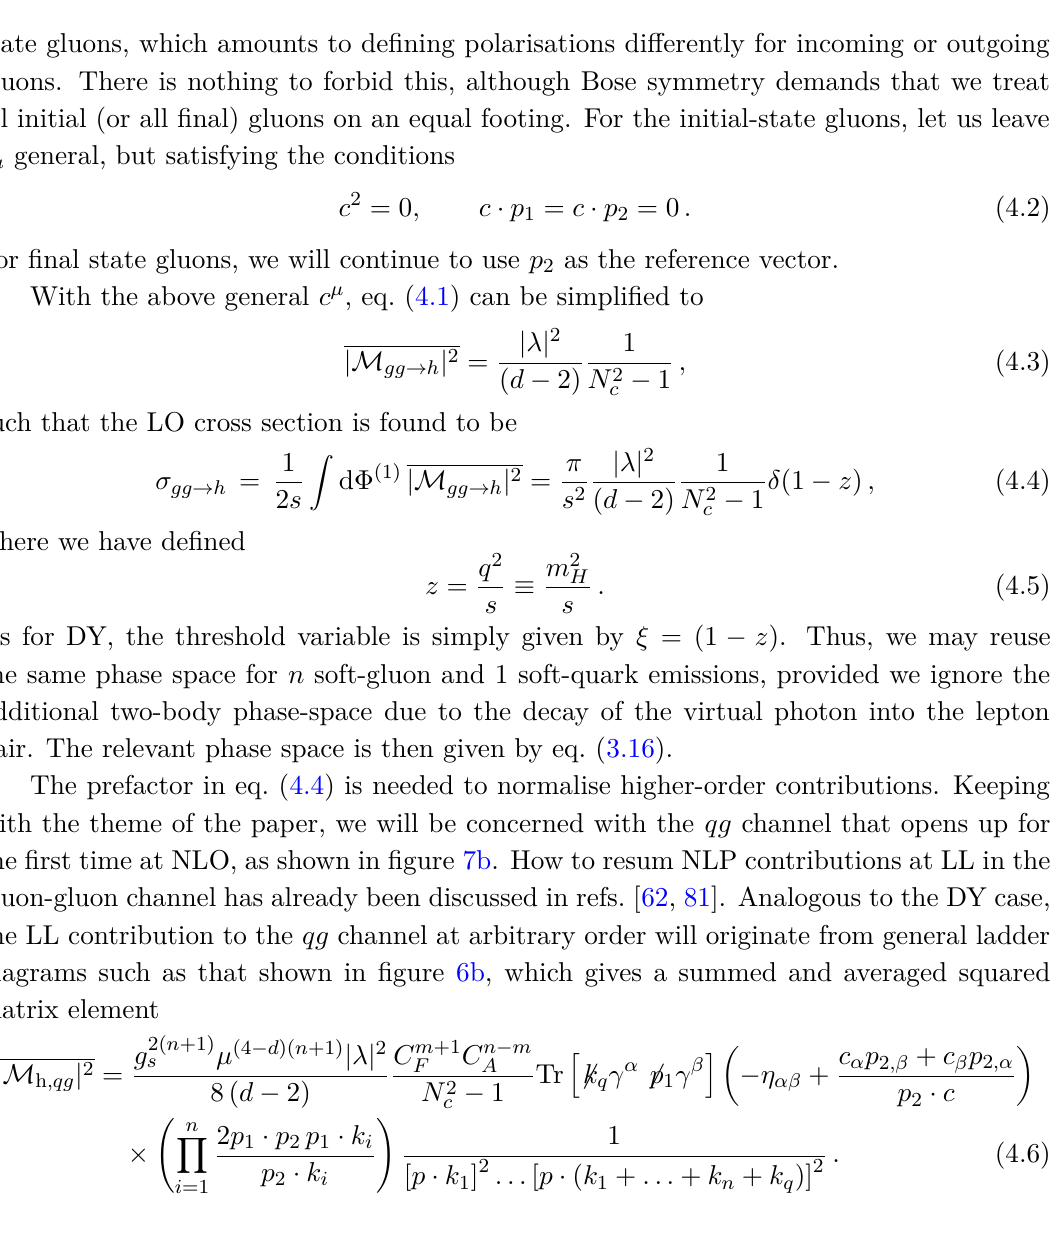
Figure 7. (a) LO squared amplitude for Higgs boson production via gluon-gluon fusion; (b) the quark-gluon channel at